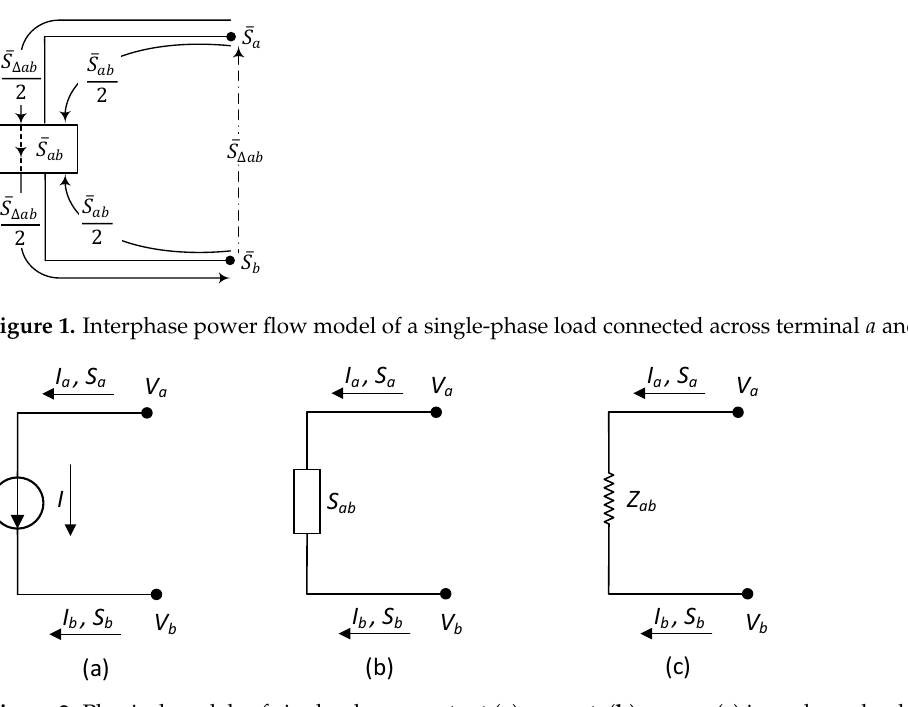
Figure 2. Physical models of single-phase constant ( a ) current, ( b ) power, ( c ) impedance